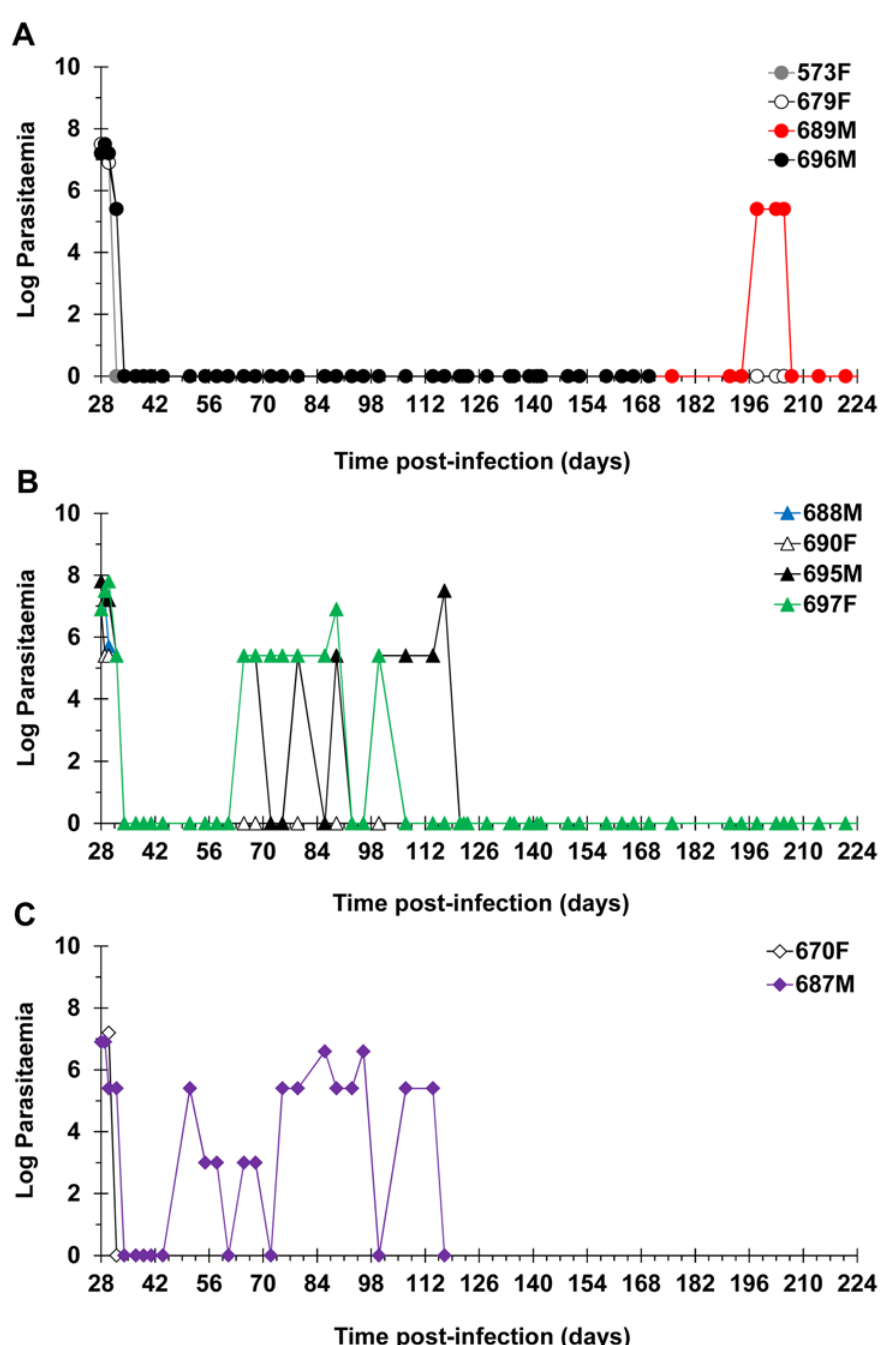
Fig 5. Primary and relapse parasitaemia in infected vervet monkeys treated with the diamidine prodrug DB868. DB868 was administered orally at ( A ) 20 mg/kg/day, ( B ) 10 mg/kg/day, or ( C ) 3 mg/kg/day for 10 consecutive days following infection with T. b. rhodesiense KETRI 2537 (28 – 37 days post-infection); the monkeys were confirmed to have progressed to second stage HAT before initiation of treatment. Relapse infections occurred at different times in specific individuals. Relapsed monkeys were rescue-treated with melarsoprol administered intravenously at 3.6 mg/kg/day for 4 consecutive days. F, female; M, male.